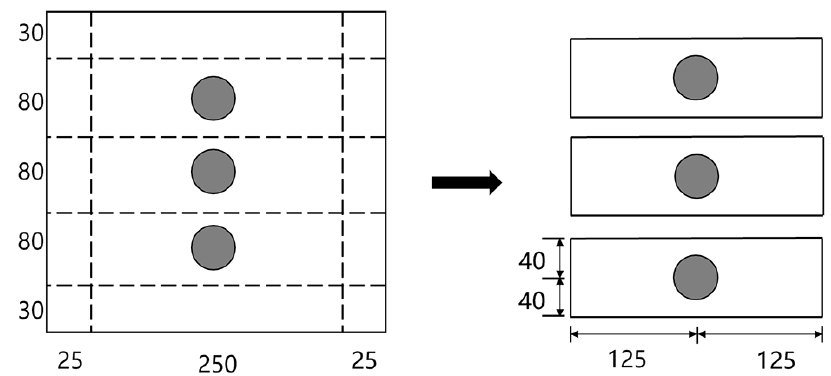
Figure 3. Dimension of beam specimen (unit: mm).